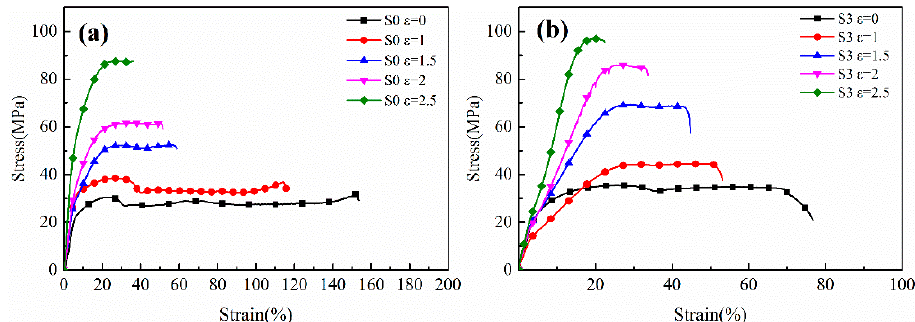
Figure 10. The stress-strain curves of the stretched ( a ) PA612 and ( b ) PA612 / SiO 2 films. (The curves were recorded at room temperature).